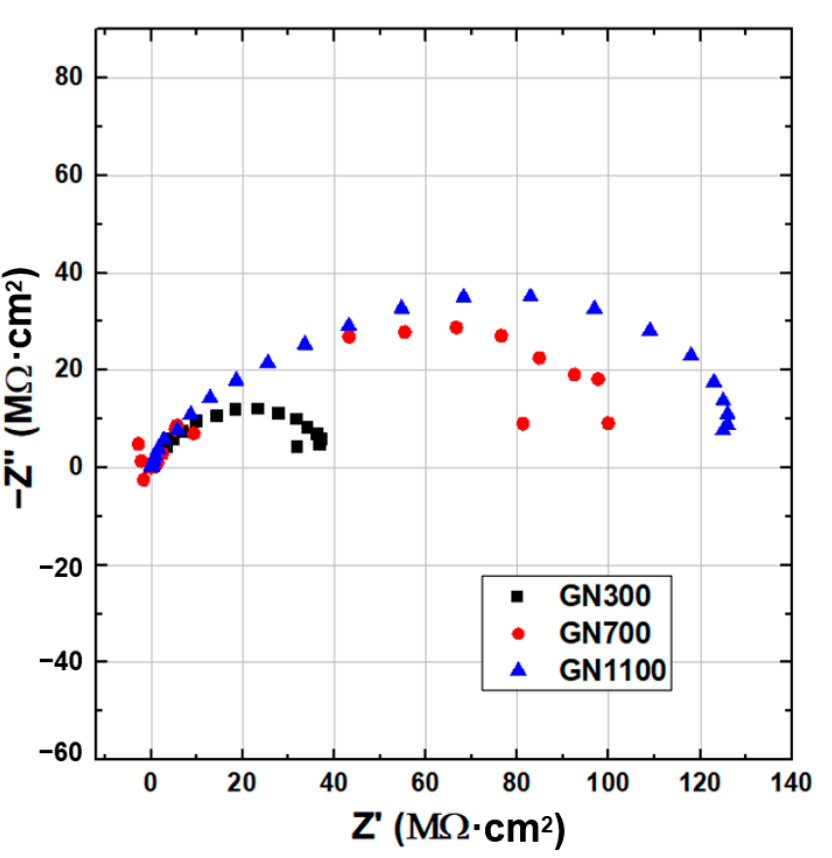
Figure 10. Nyquist plots of EIS for coatings filled with 0.05 wt.% of GN reduced at different temper- atures (GN300, GN700 and GN1100) immersed in 3.5 wt.% NaCl solution.